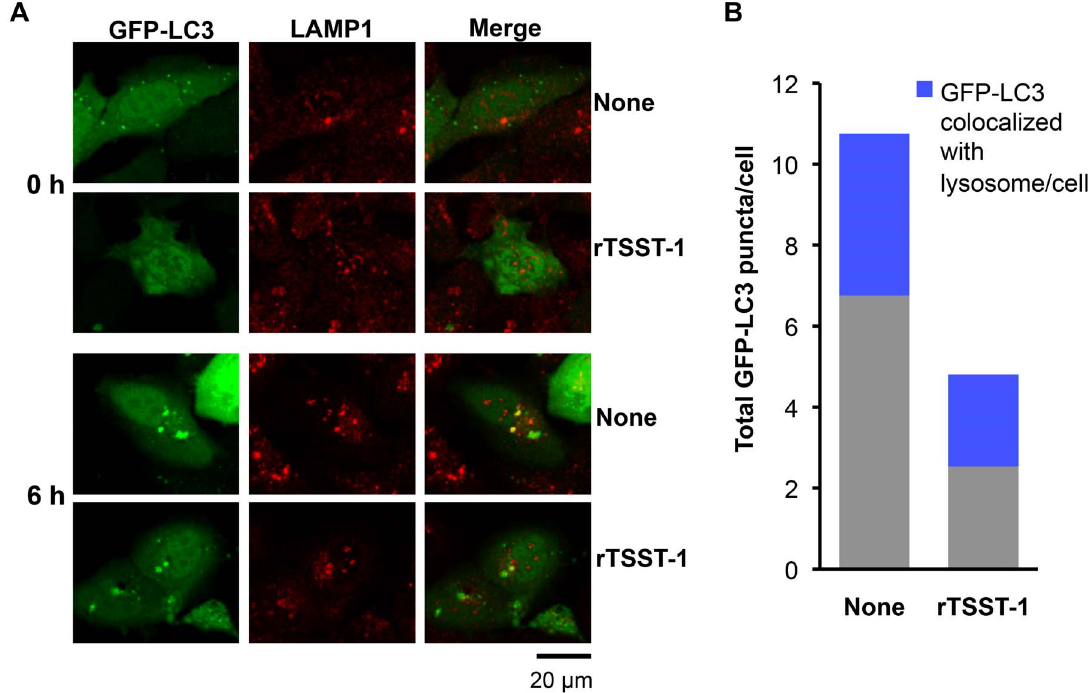
Figure 2. rTSST-1 does not enhance autophagosome and lysosome fusion. HeLa 229 cells were transfected with pEGFP-hLC3. Autophagy was induced under nutrient-starvation condition for 0 and 6 h with or without the addition of 10 m g/ml rTSST-1. Lysosomes were immunostained with LAMP1, lysosomes and GFP-LC3 puncta were observed under confocal microscope (A). GFP-LC3 puncta and overlapping between GFP-LC3 and lysosomes were counted from 100 cells of 2 independent-experiments (B).